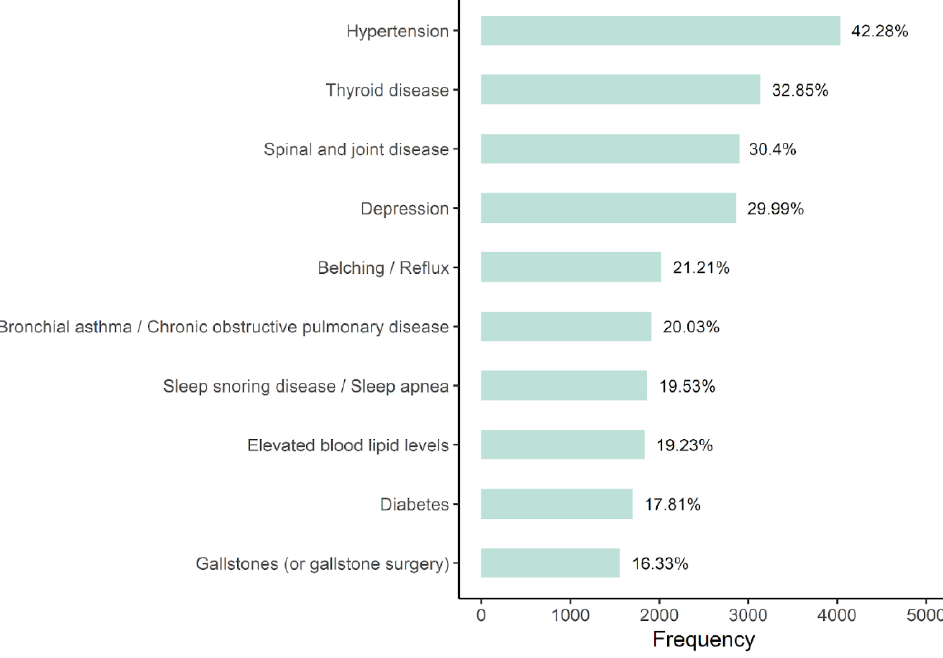
Figure 2. Frequencies of the ten most frequently reported comorbidities. Given are both absolute ( x -axis) and relative values. Data of n = 1784 (15.8%) patients were not available.